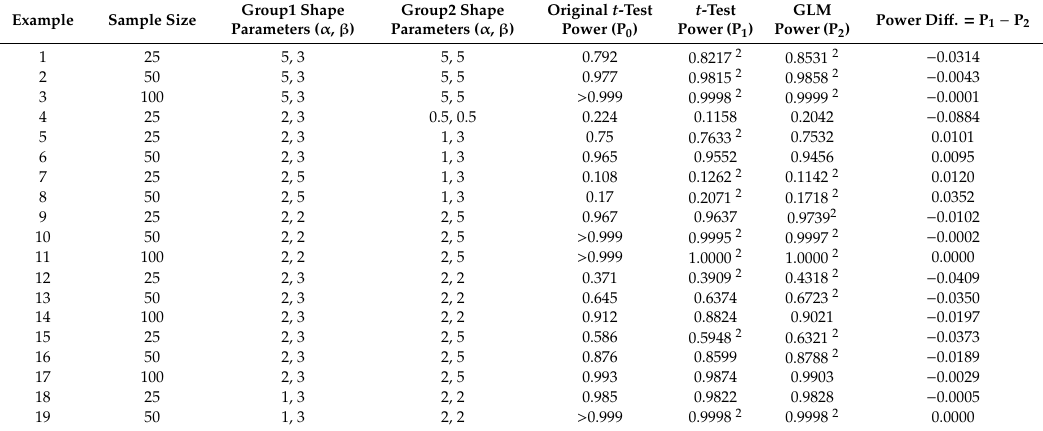
Table 3. Power values for beta distributed data tested using the t -test and GLM: P 0 is the power value of the two-group t -test calculated prior to the simulations, P 1 is the empirical power of the two-group t -test conducted on the log-transformed groups, and P 2 is the empirical power of the GLM-fitted data. Example